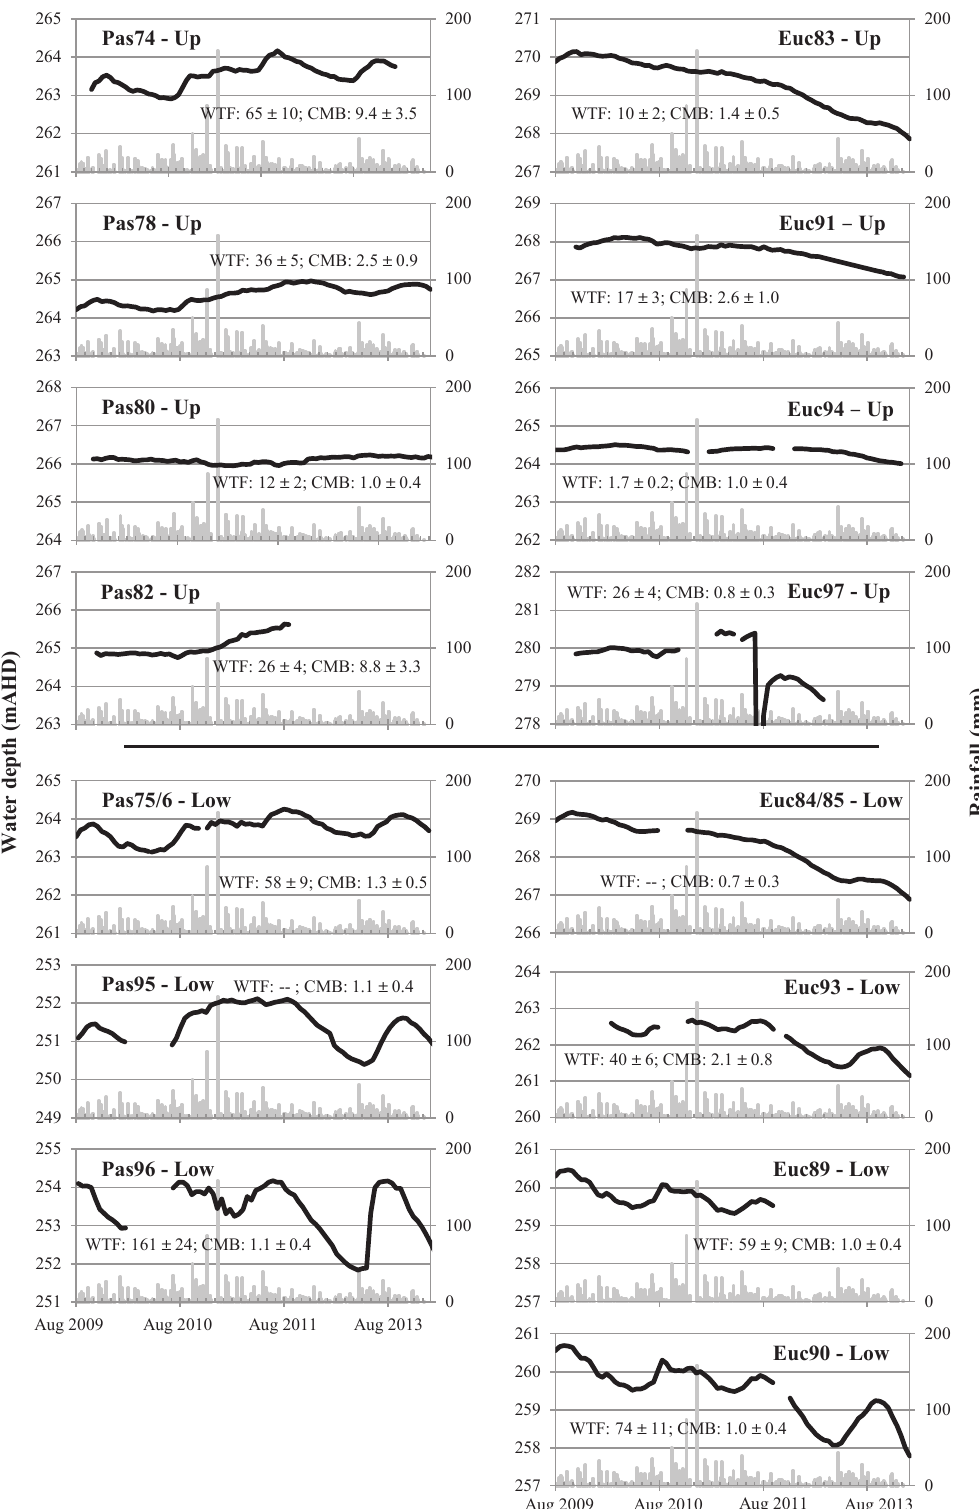
Figure 4. Bore hydrographs, rainfall and recharge estimates (in mmyr − 1 from Table 3), for the water table fluctuation and chloride mass balance methods. Hydrographs are sorted by landscape position – lowland or